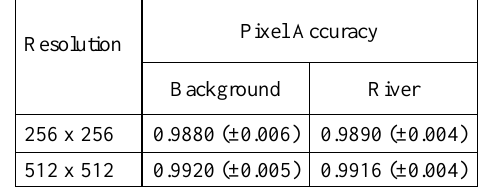
Table 1. Results using pixel accuracy in the subset of images.